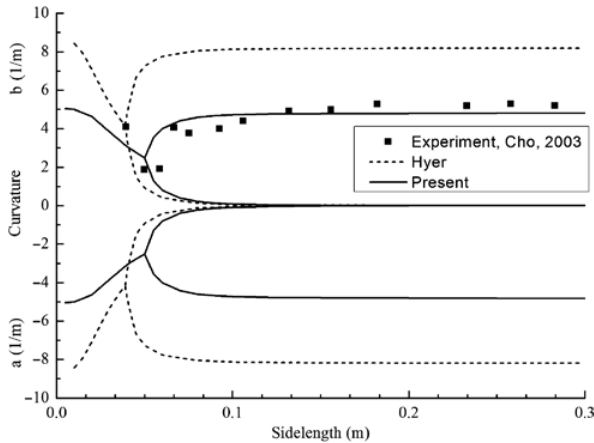
Figure 8: Change of curvature as a function of the side length for [0 /90 ] laminate for the rubber tool. 2 2 T